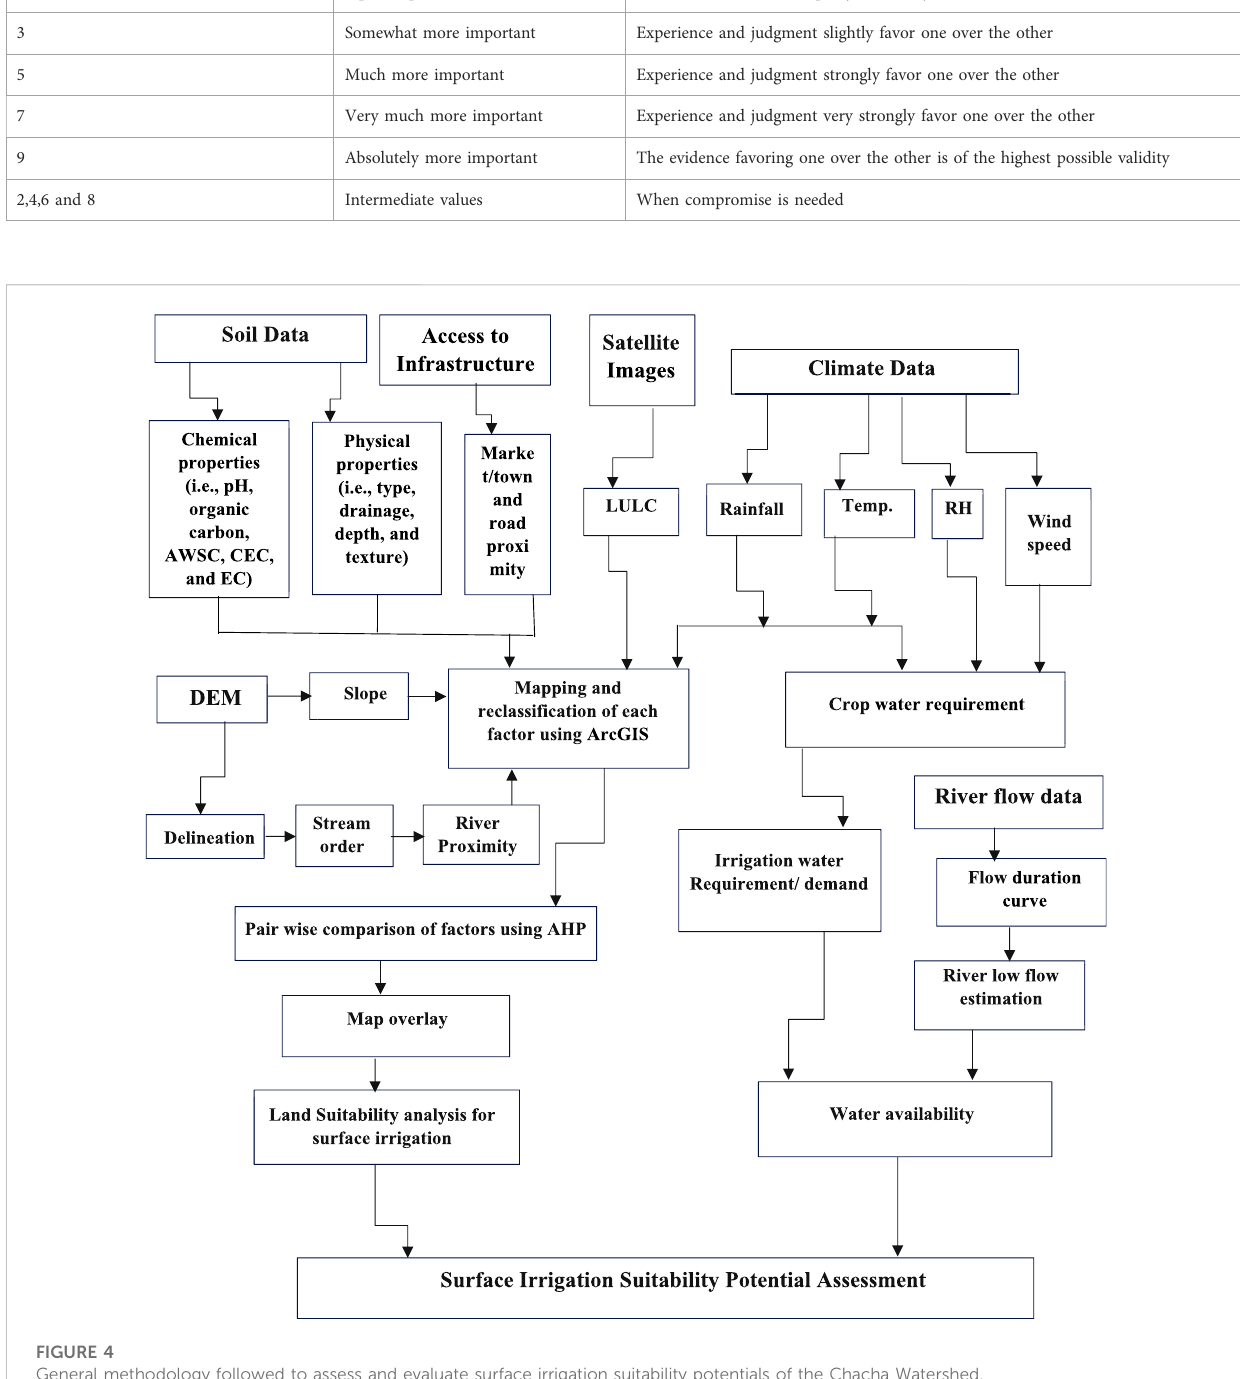
FIGURE 4 General methodology followed to assess and evaluate surface irrigation suitability potentials of the Chacha